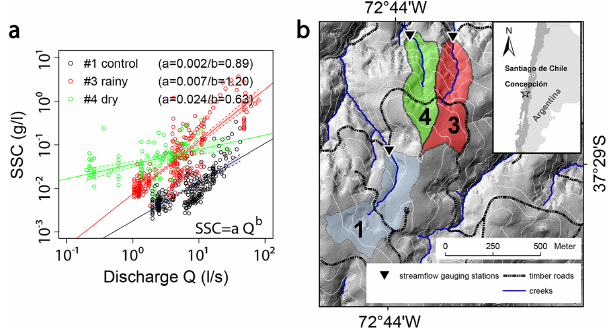
Figure 1. (a) Sediment rating curves for the catchments with fitted power-law intercepts a (gs b L − ( b + 1) ), slopes b , and 95% confidence intervals about regression lines. (b) Location of study catchments (star in inset) including stream gauges, nearest rain gauge, and un- paved timber roads. Topography derived from lidar survey; contour spacing is 20m. Numbers (consistent with previous work) refer to catchments. See Huber et al. (2010), Mohr et al. (2012), and Mohr et al. (2013) for detailed descriptions of these